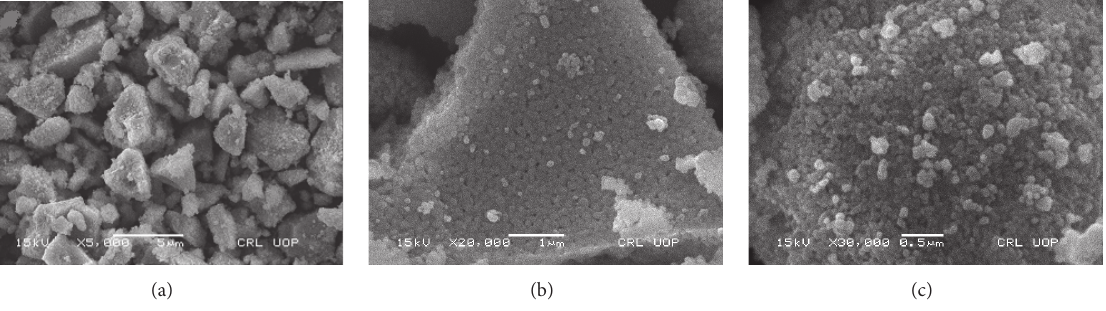
Figure 1: SEM images of 0.01 wt% Pt/ZrO 2 as a catalyst.